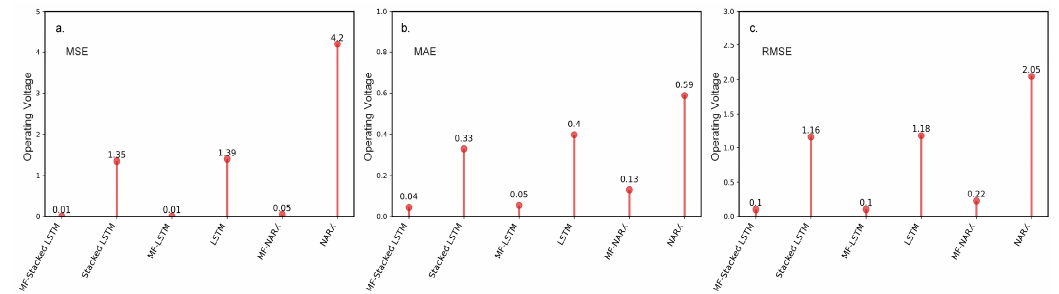
Figure 6. The resulting MSE, MAE, and RMSE with different approaches for the operating voltage. ( a ) The results for the MSE; ( b ) The results for the MAE; ( c ) The results for the RMSE.